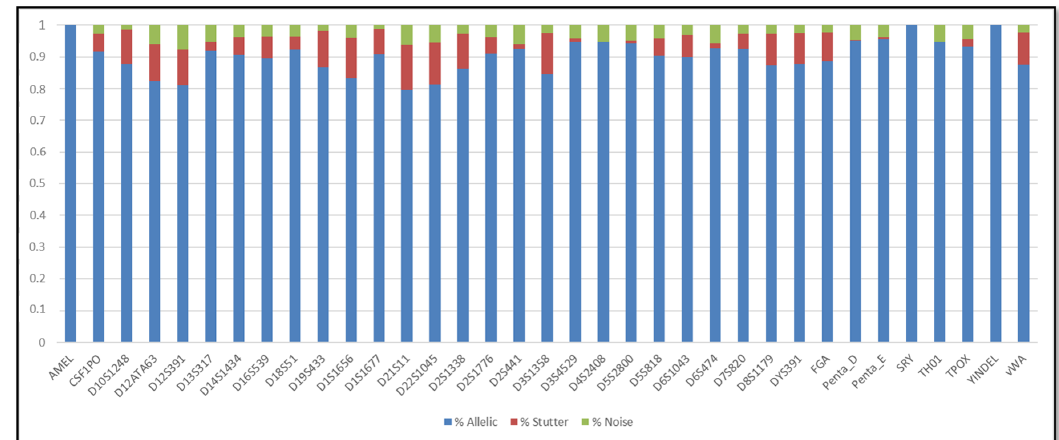
Figure 2. Sequence coverage ratios of the urine samples.